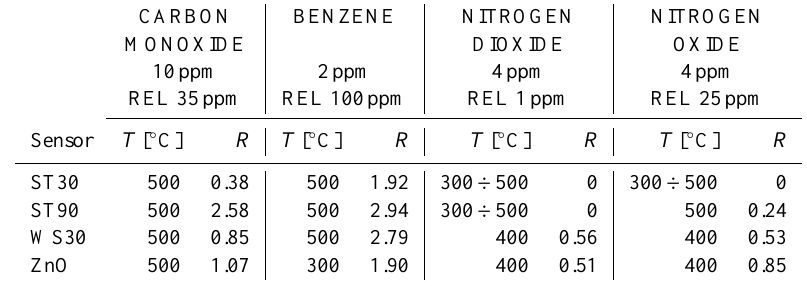
Table 3. The optimal working temperatures T best and the corresponding responses for all analyzed films tested with interfering gases. CARBON